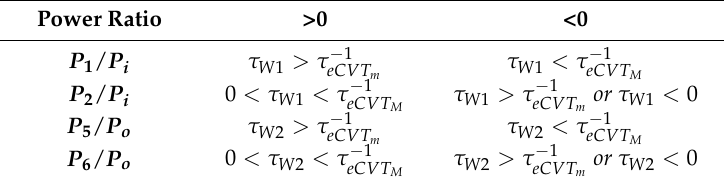
Table 1. Case 1—Power ratios